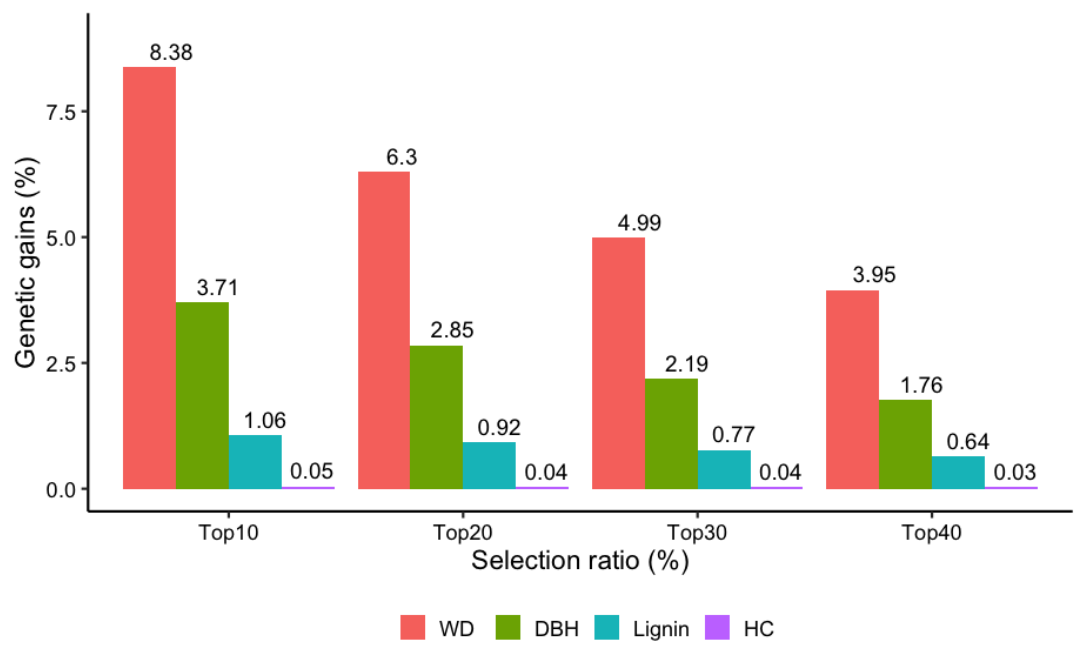
Figure 4. Realised genetic gains of four wood traits at age 24 for P. elliottii . Selection ratio ranged from 10% to 40% of the total family numbers; genetic gains was calculated as improved percentage.